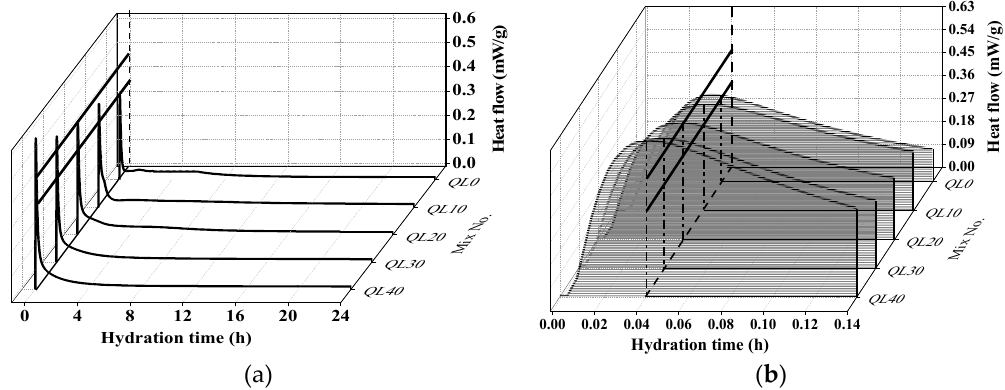
Figure 7. Effect of quicklime on the hydration heat flow: ( a ) 0–24 h, ( b ) 0–0.14 h. Figure 7. E ff ect of quicklime on the hydration heat flow: ( a ) 0–24 h, ( b ) 0–0.14